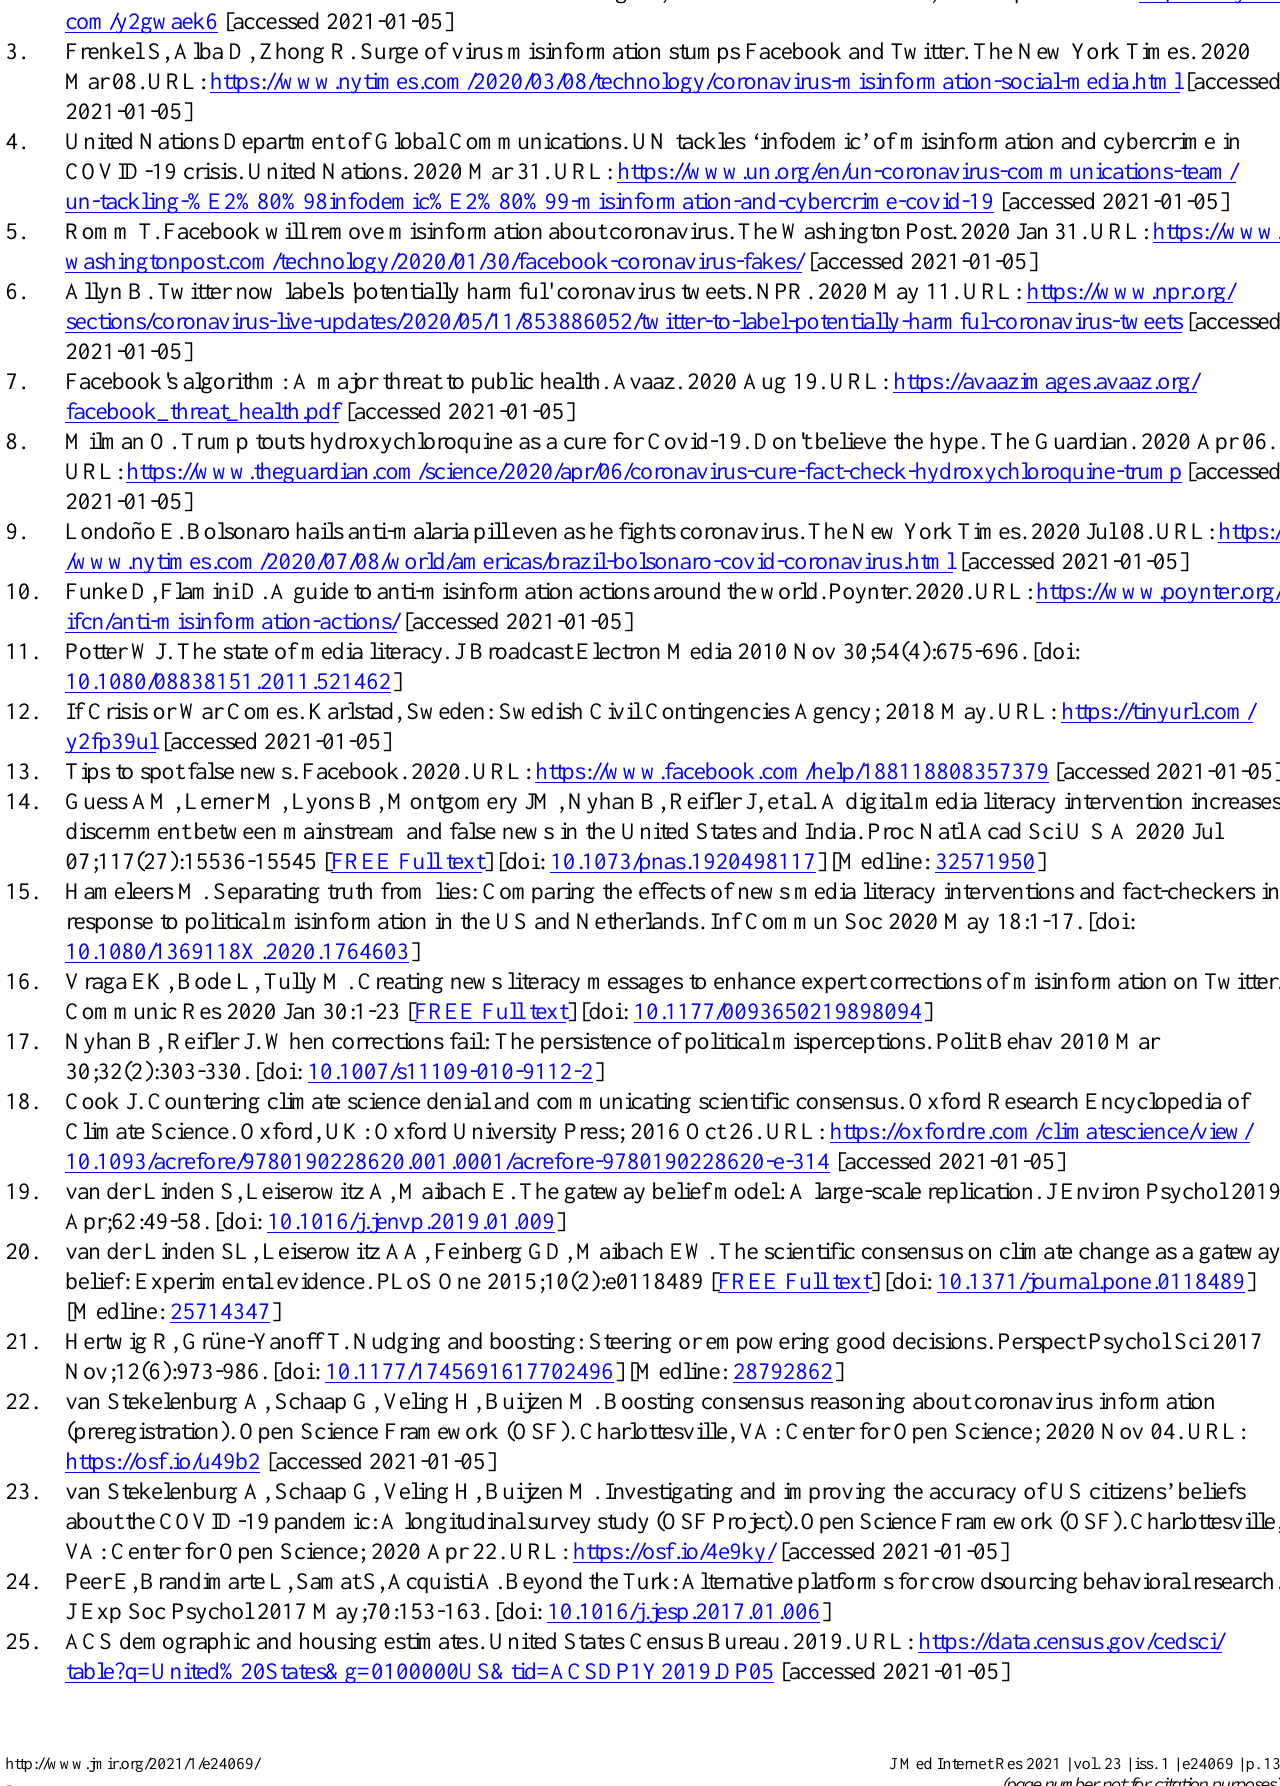
table?q=United%20States&g=0100000US&tid=ACSDP1Y2019.DP05 [accessed